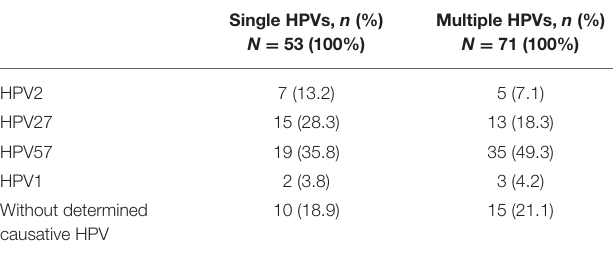
TABLE 4 | Determined causative HPV types in 53 randomly selected warts with single human papillomavirus (HPV) infections and 71 warts with multiple HPV infections based on estimated type-specific HPV viral loads and set cutoff